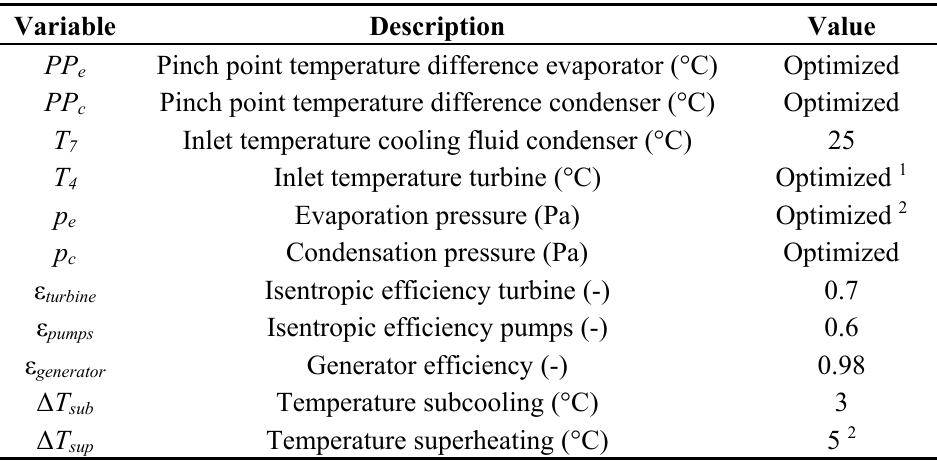
Table 3. Thermodynamic cycle